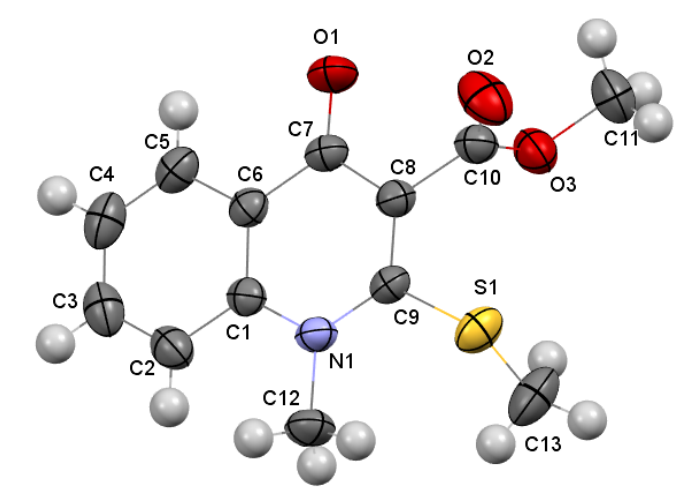
Figure 8. Molecular structure of compound 5 according to X-ray diffraction data. Thermal displacement ellipsoids are shown at the 50% probability level.